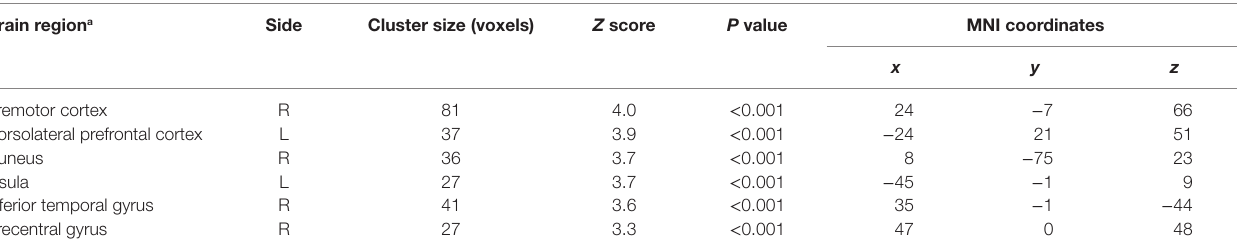
TaBle 3 | The brain regions where gray matter volume was positively correlated with the masticatory performance index. Brain region a